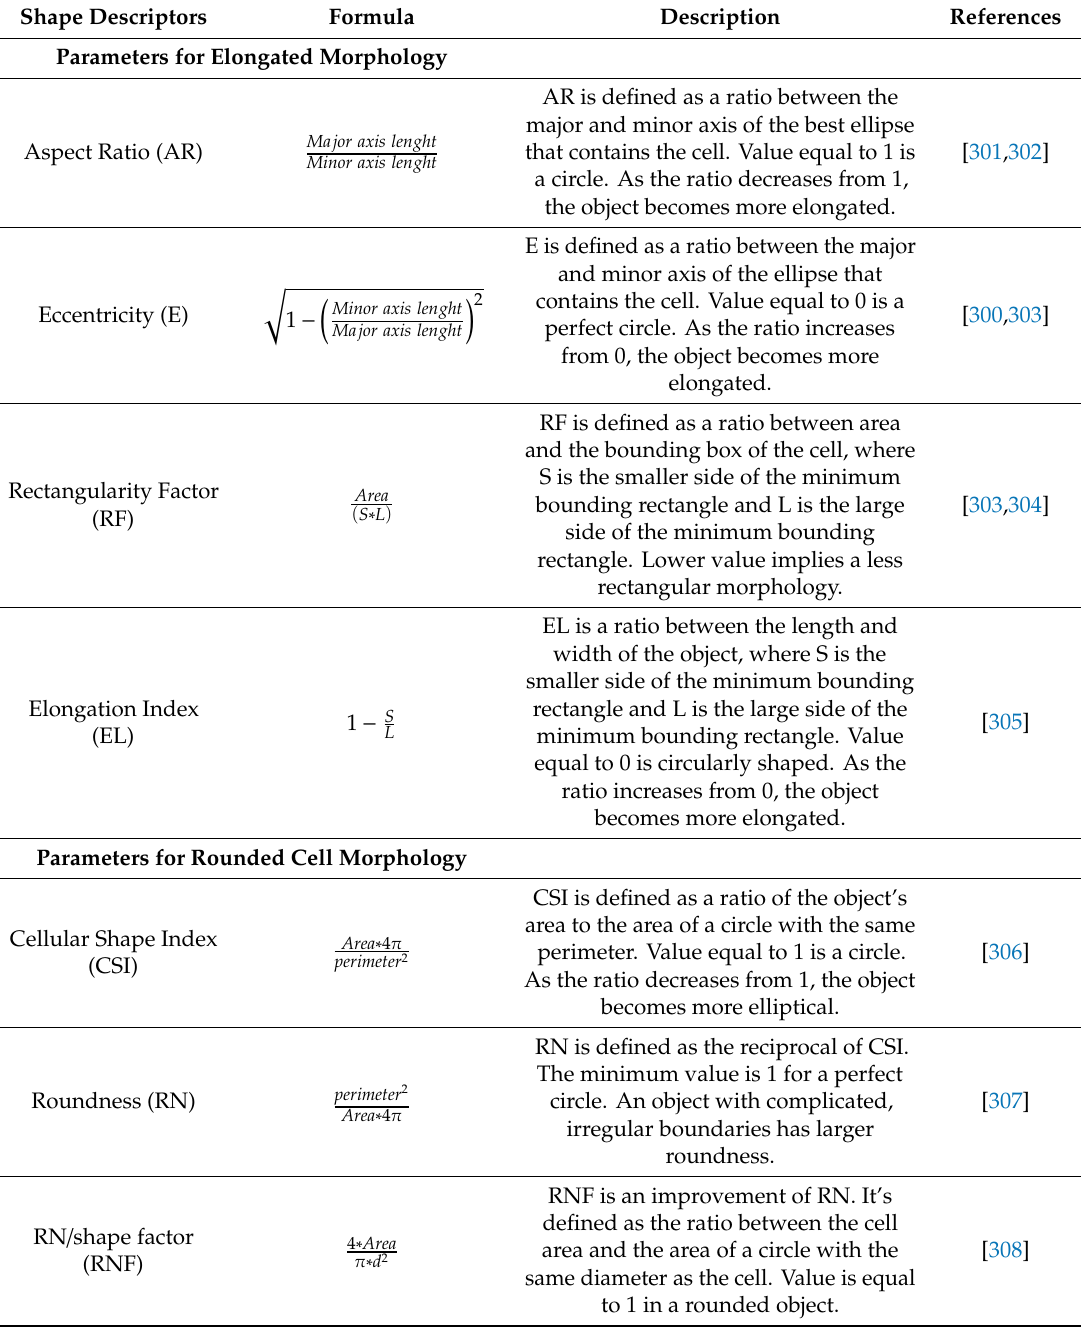
Table 4. Computational Morphometric